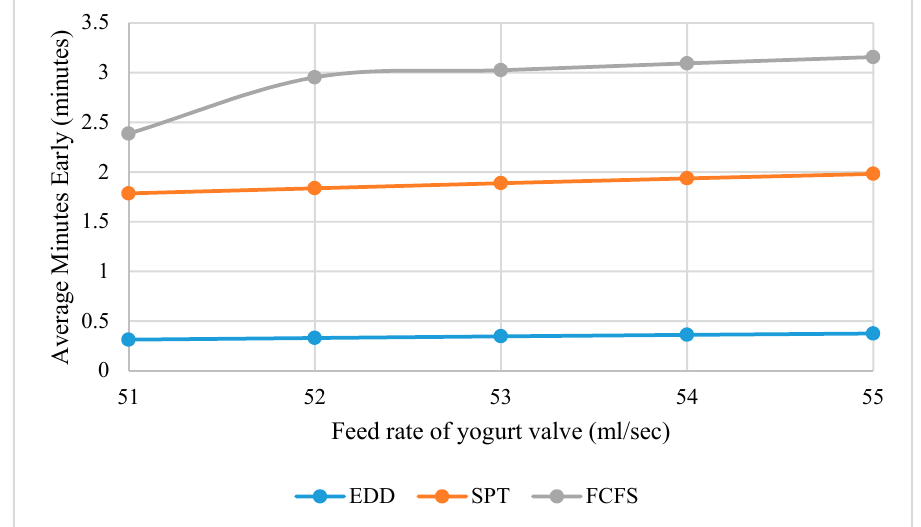
Figure 10. The effect of feed rate of yogurt valve on average flow time. The average minutes past due decreases with an increase in the feed rate of the yogurt valve. It is higher in the case of FCFS than EDD and SPT, as depicted in Figure 11. Comparing EDD and SPT, initially, the average minutes past due are greater in the case of EED than SPT, but then its valve is lower than SPT with an increase in the feed rate of yogurt.